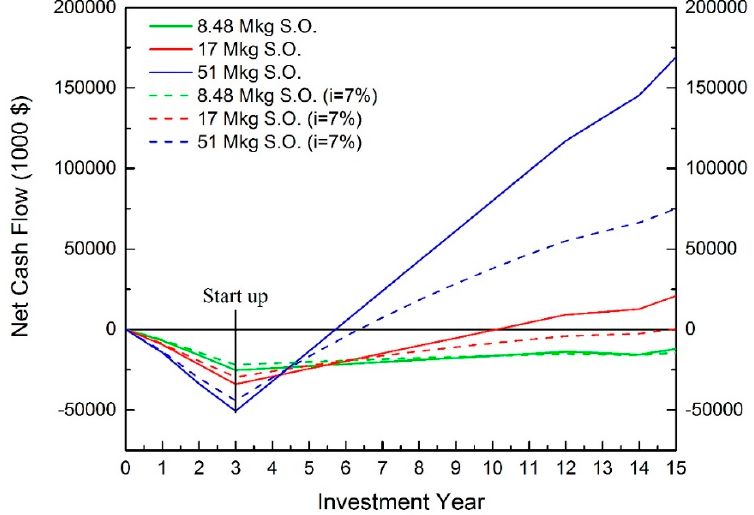
Figure 5. Cash flow of EAEP. (S.O. indicates the annual soybean oil production).